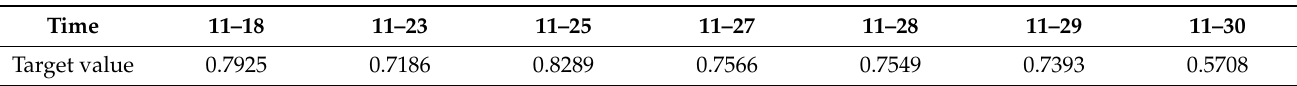
The different colored branches in the graph represent different groups. The longer the branch length between samples, the more similar the two samples are. Figure 9. Single-linkage clustering genealogy comparison chart. Figure 9. Single-linkage clustering genealogy comparison chart. Table 2. Table of cophenetic correlation coefficients for the temperature at different times.